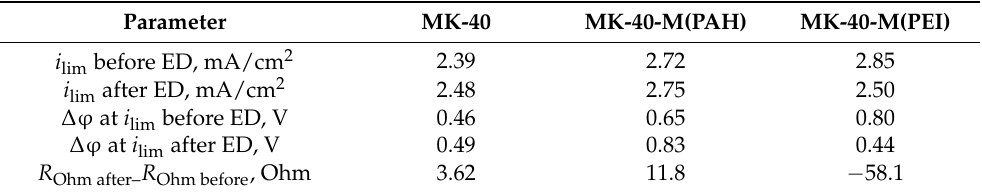
Table 1. Limiting current densities before and after the electrodialysis (ED), potential drops at the limiting current densities and the difference of average resistance at the so-called ohmic regions of i-V curves of the studied membranes.